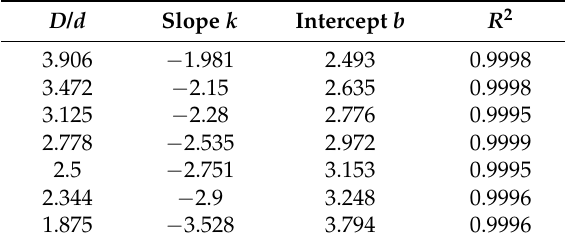
Table 5. Linear fitting parameters of ln( C vs )~ h / d .